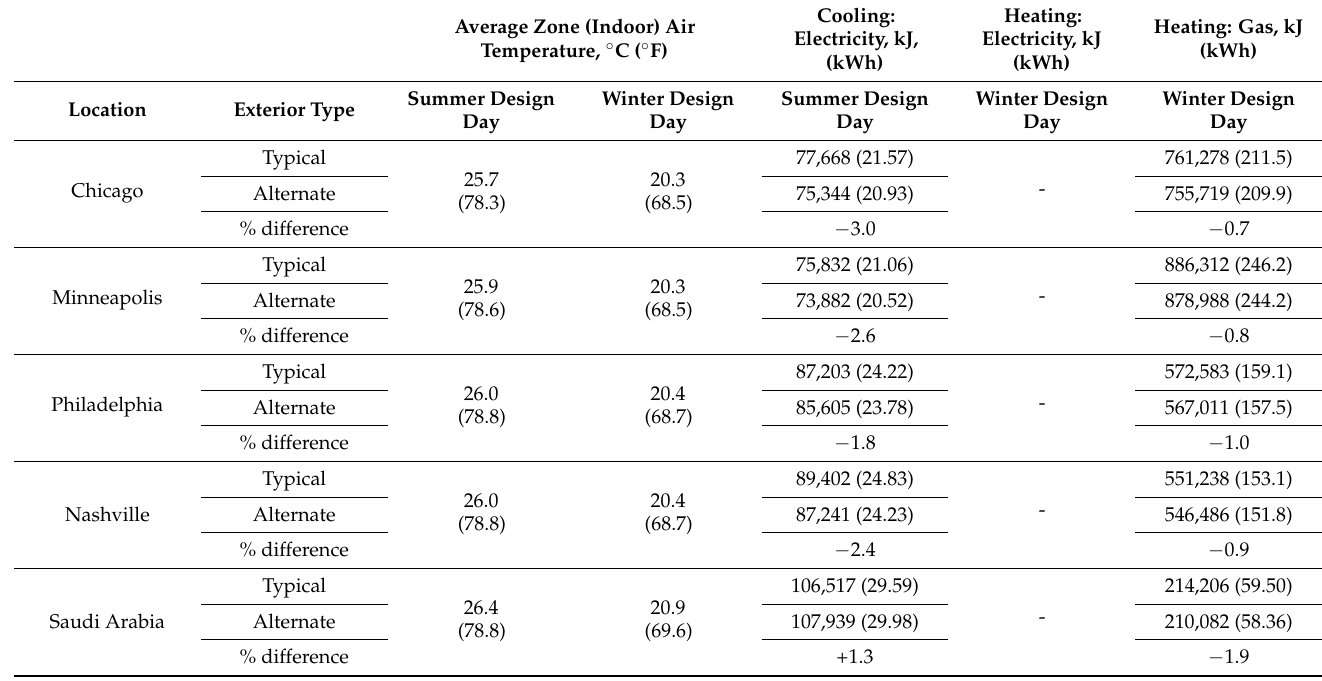
Table 12. Results for strip mall reference model building energy